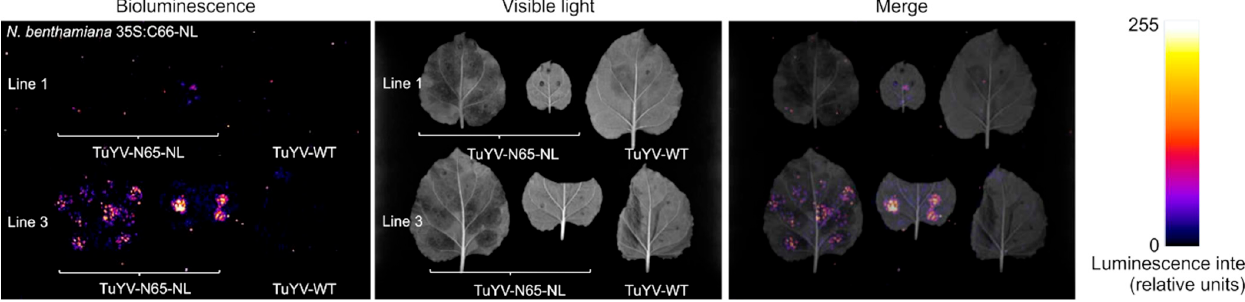
Figure 6. Detection of TuYV ‐ N65 ‐ NL bioluminescence in two transgenic Nicotiana benthamiana lines (1 and 3) expressing C66 ‐ NL from a 35S promoter. Nano ‐ Glo substrate was infiltrated in an upper, systemically infected leaf three weeks after agro ‐ infiltration with TuYV ‐ N65 ‐ NL. A leaf systemically infected with wild ‐ type TuYV (TuYV ‐ WT) was infiltrated with Nano ‐ Glo as a negative control. Bi ‐ oluminescence or visible light was recorded in a G ‐ box. Luminescence intensity is presented in